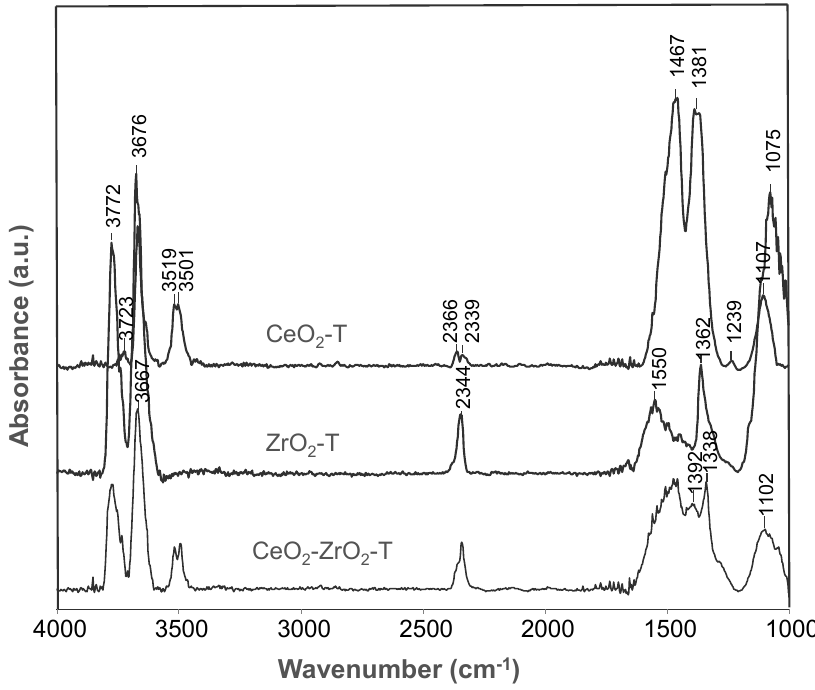
Figure 5. IR spectra of activated (500 °C, 2 h, vacuum) oxidized CeO 2 -, ZrO 2 - and CeO 2 -ZrO 2 -catalysts at 50 °C.